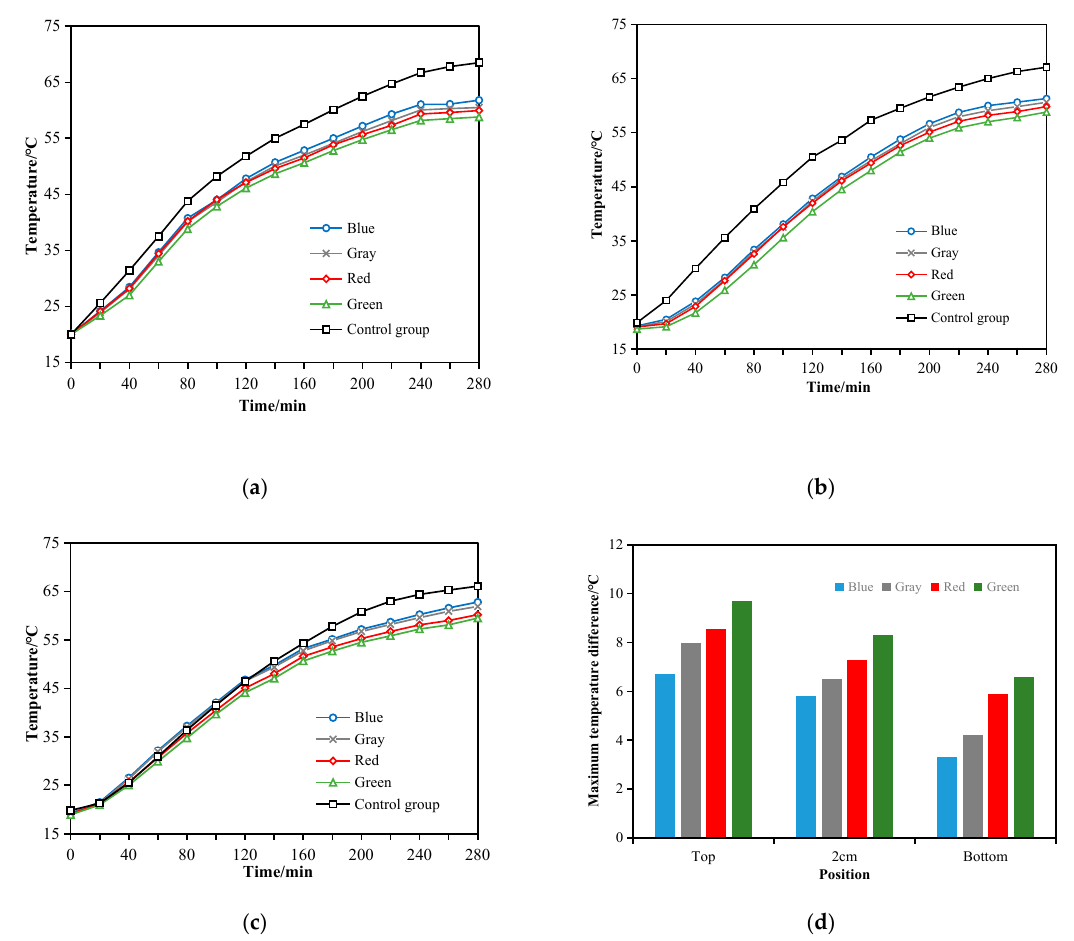
Figure 13. Cooling performance of different color coatings: ( a ) The upper surface temperature of the specimen; ( b ) Temperature at 2 cm of the specimen; ( c ) Temperature at the bottom of the specimen; ( d ) Maximum temperature difference with the control group.